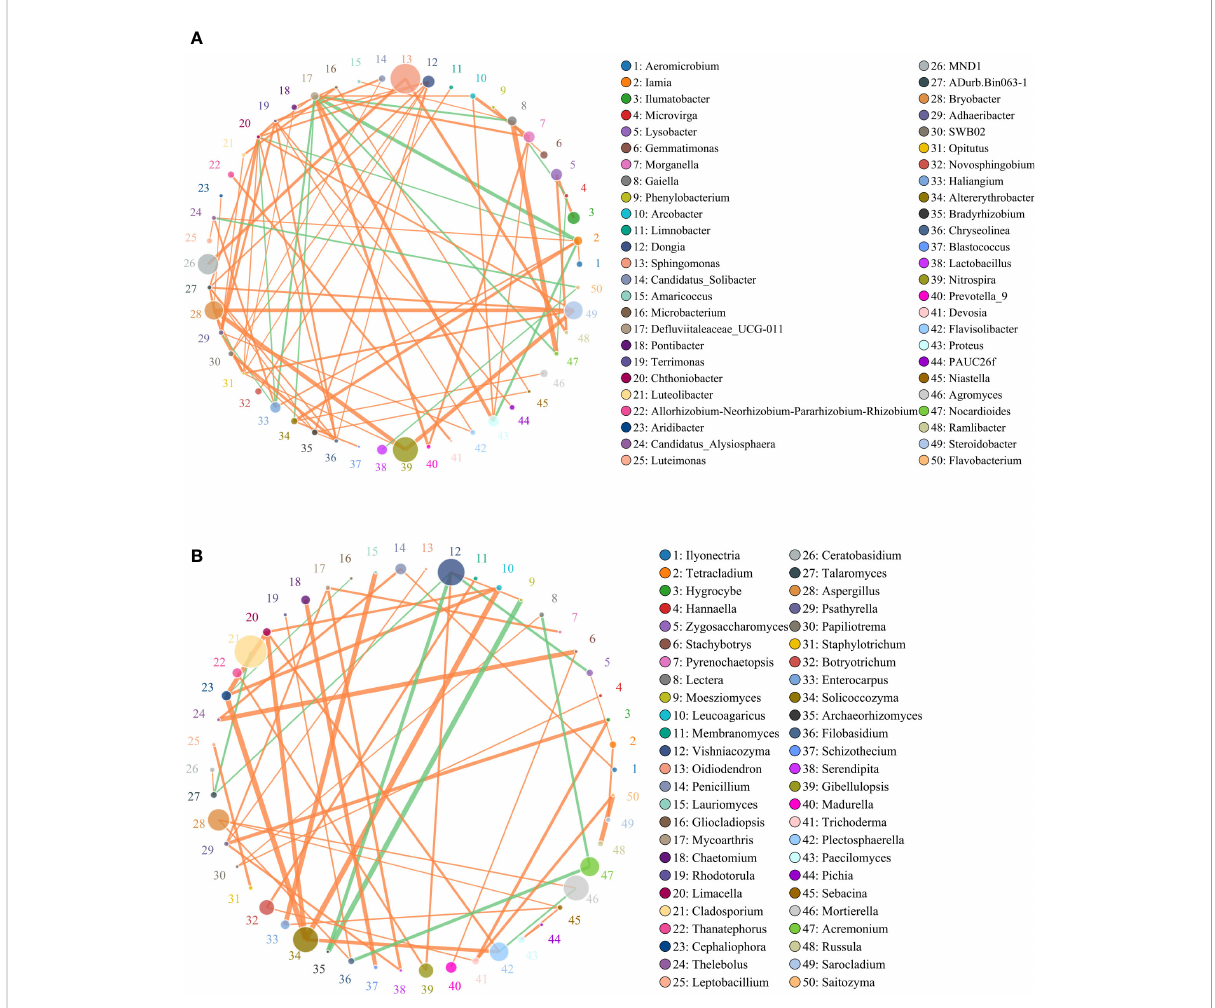
FIGURE 6 Circles represents species, size of circle represents the abundance; (A) means the results of bacterial and (B) means the results of fungal. The edges represent the correlation between the two species, the thickness of the edge represents the strength of the correlation, and the color of the line: orange represents the positive correlation, while green represents the negative